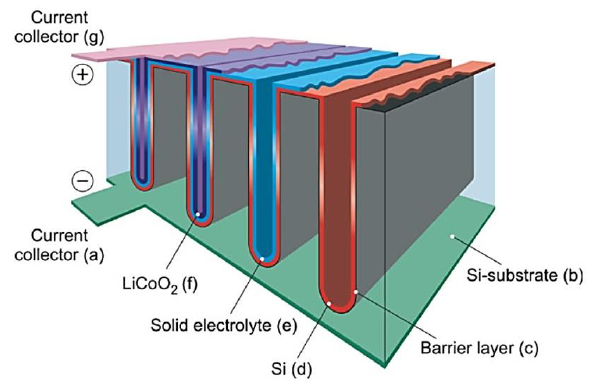
Figure 36. Schematic diagram of three-dimensional microbattery with lithium phosphorous oxynitride electrolyte. Reproduced with permission from [439]. Copyright 2007 Wiley.